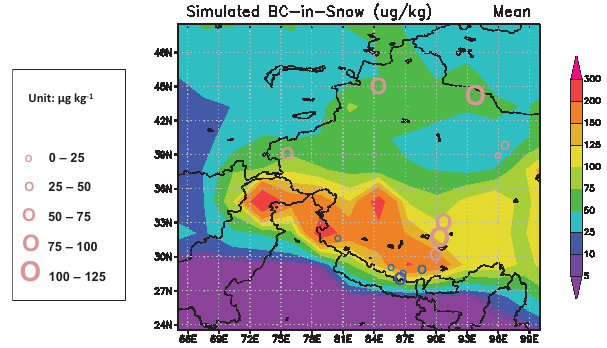
Fig. 4. Simulated annual mean (shaded) against measured (in circle) BC content in snow (Unit: ugkg − 1 ). The observation is from Xu et al. (2006) and Ming et al.